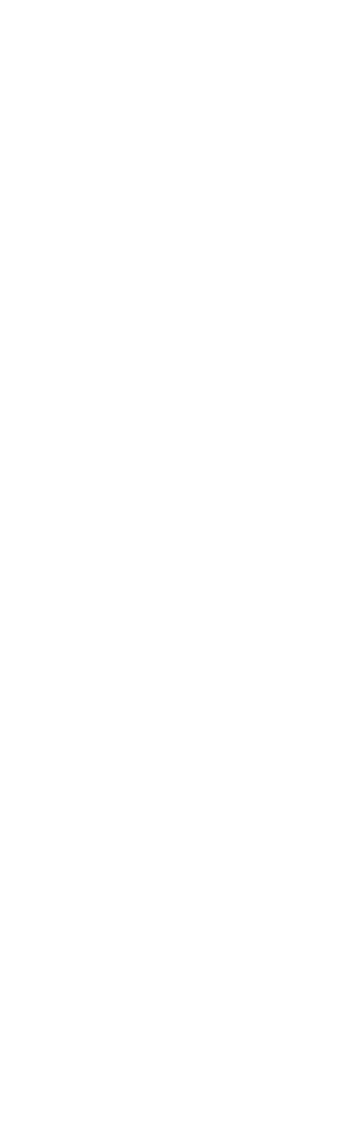
FIGURE 3 | GO and KEGG analysis of the role of DEGs and screening enrichment pathways. (A) From the aspects of biological processes, cellular components, and molecular functions, select the top 10 most signi fi cant terms and draw a histogram for display. The abscissa in the fi gure is the description of GO Term, and the ordinate is the signi fi cance level of GO Term enrichment. The higher the value, the more signi fi cant. Orange represents BP, green represents CC, and blue represents MF. (B) Select the 20 most signi fi cant KEGG pathways to draw a scatter diagram for display. The abscissa in the fi gure is the ratio of the number of differential genes annotated to the KEGG pathway to the total number of differential genes, the ordinate is the description of the KEGG pathway, the size of the dot represents the number of genes annotated to the KEGG pathway, and the color from red to purple represents enrichment of the saliency